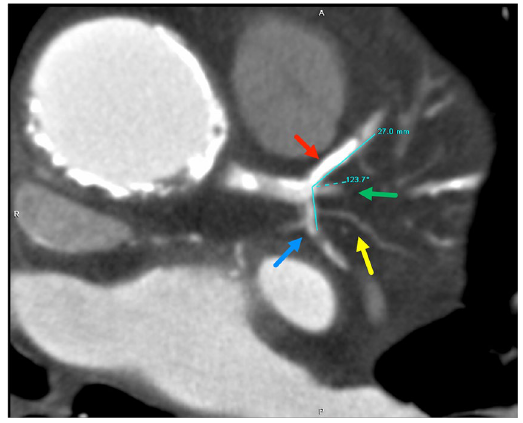
Figure 2. A 73-year-old male who had significant stenosis of the LAD (red arrow) and the LCX (dark blue arrow). The calcium score of the LAD was 670. The total calcium score was 3775. The angle between the LAD and the LCX (dark blue arrow) was 123.7°. The ramus intermedius (green arrow) and obtuse marginal branch 1 (yellow arrow) are also obvious in the axial